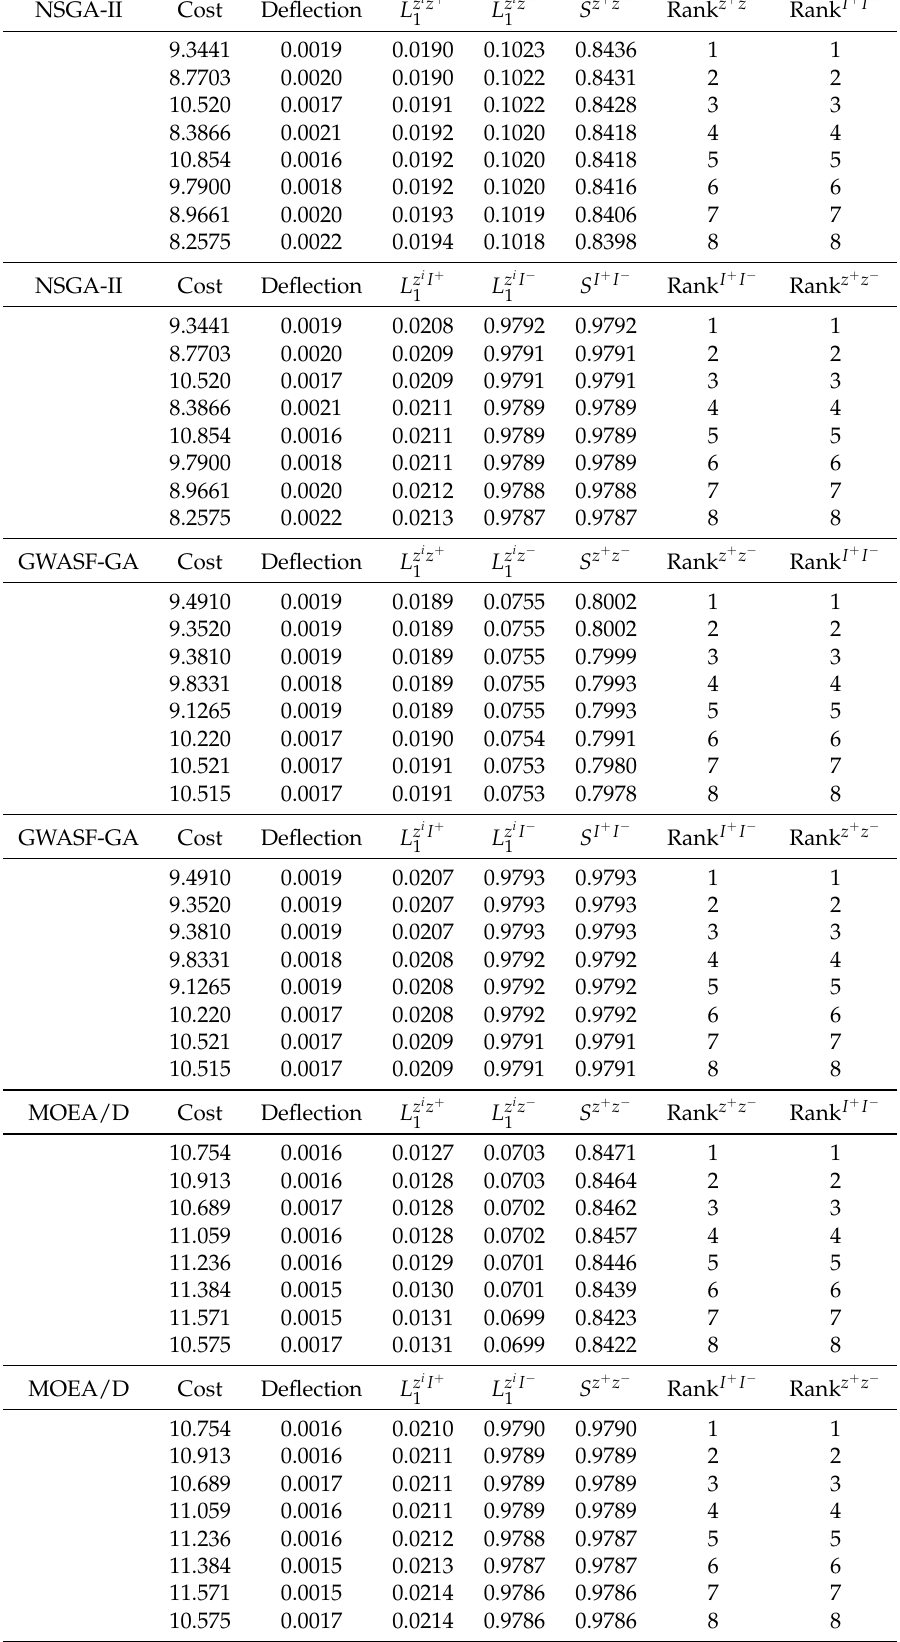
Table 4. TOPSIS ranking results with L 1 metric for NSGA-II, GWASF-GA and MOEA/D ( N = 100).